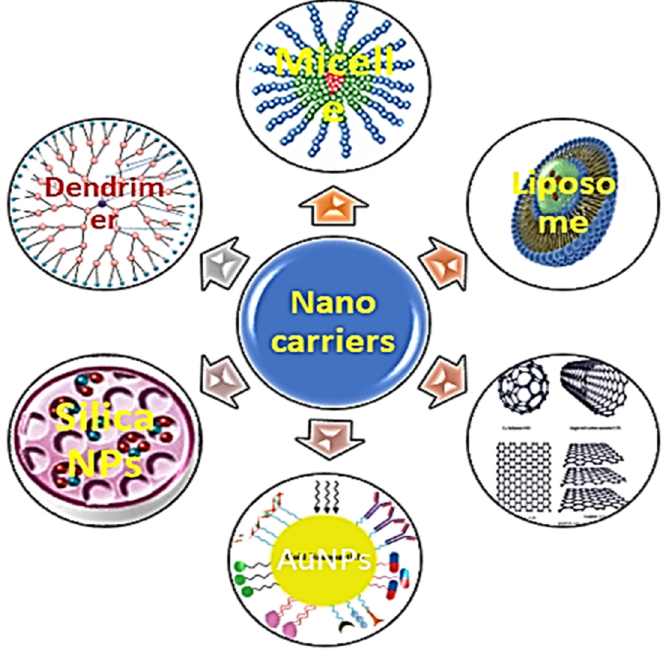
Figure 4. Types of different nanocarriers.